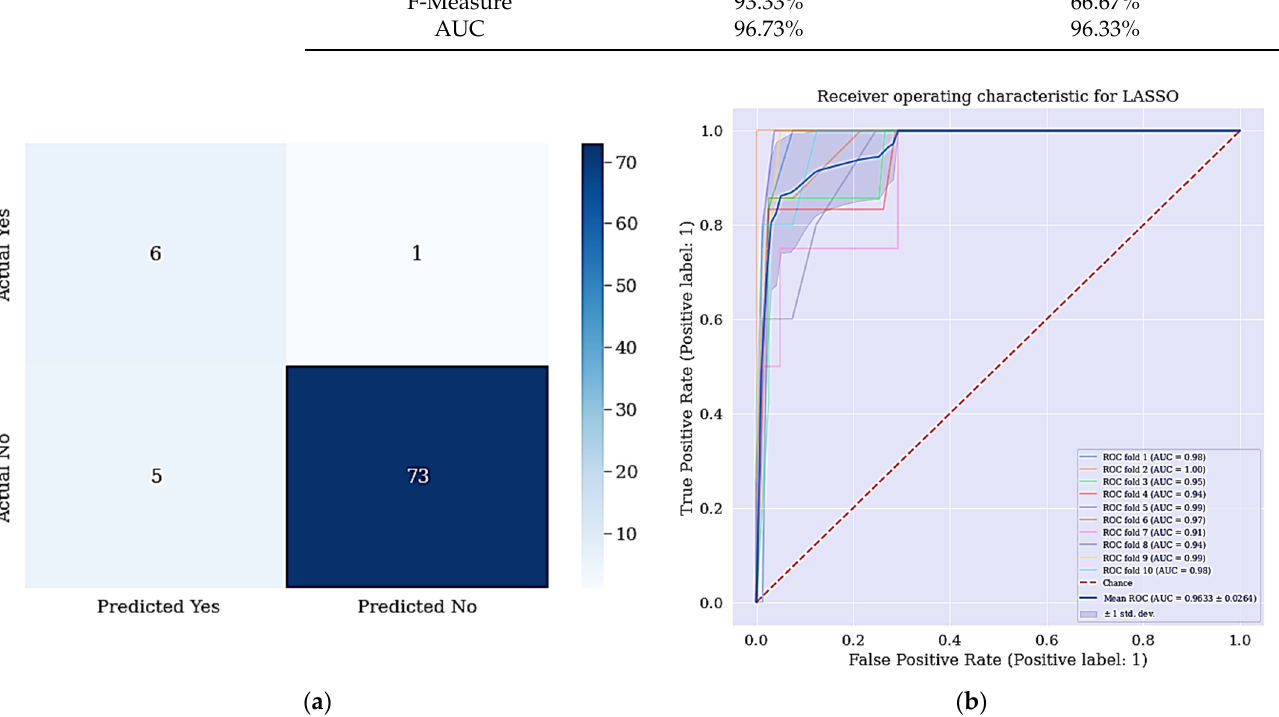
Figure 6. ( a ) Confusion matrix for DT + LASSO + SMOTETomek and ( b ) ROC Curve for DT + LASSO + SMOTETomek techniques. ( a ) shows the confusion matrix of DT + LASSO + SMOTETomek and its resulting AUC.